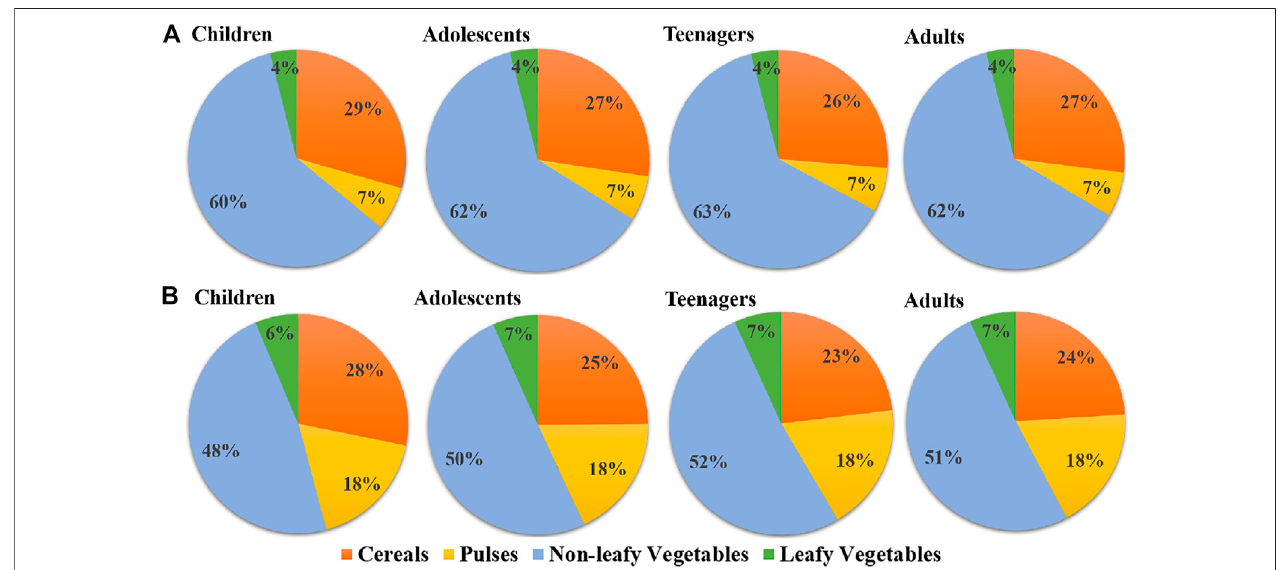
FIGURE4| Fluorideexposurethroughdietaryintakeofcereals,pulses,andnonleafyandleafyvegetablesinthestudiedagegroupfrom (A) Bankuraand (B) Purulia districts.